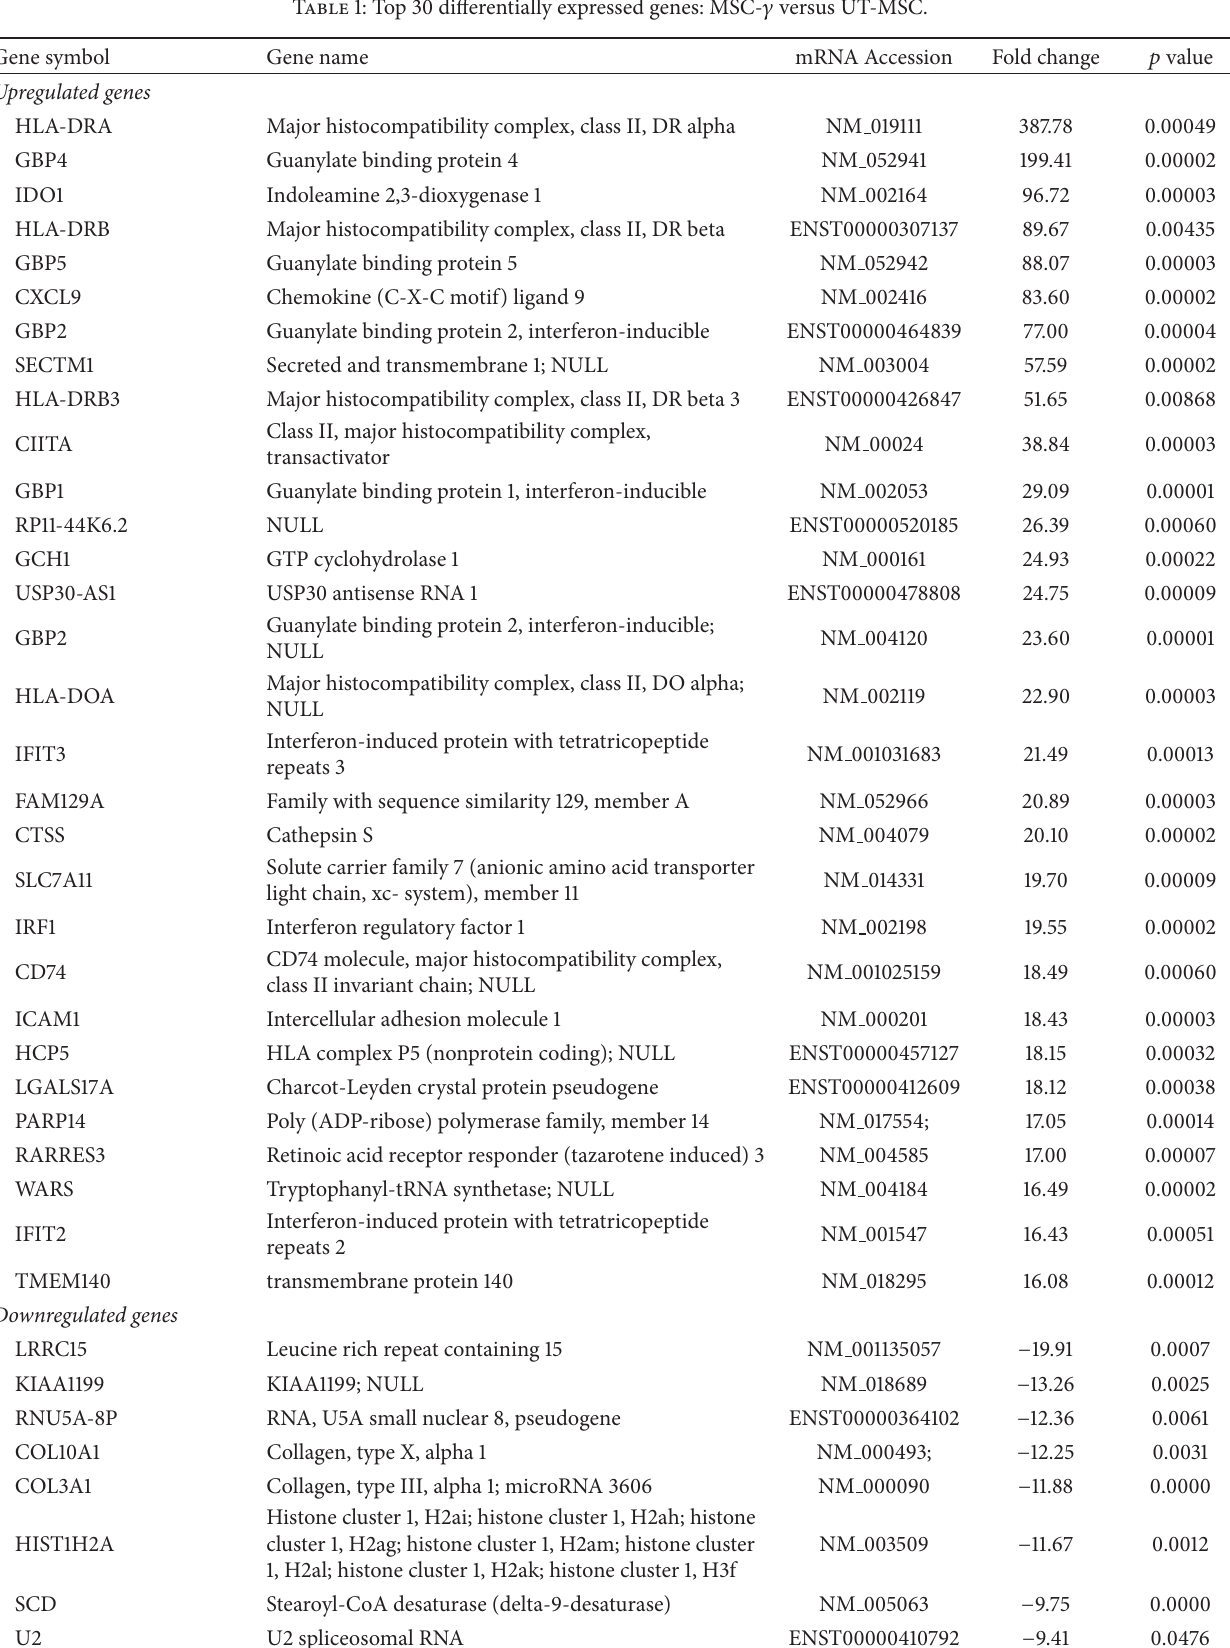
Table 1: Top 30 differentially expressed genes: MSC- 𝛾 versus